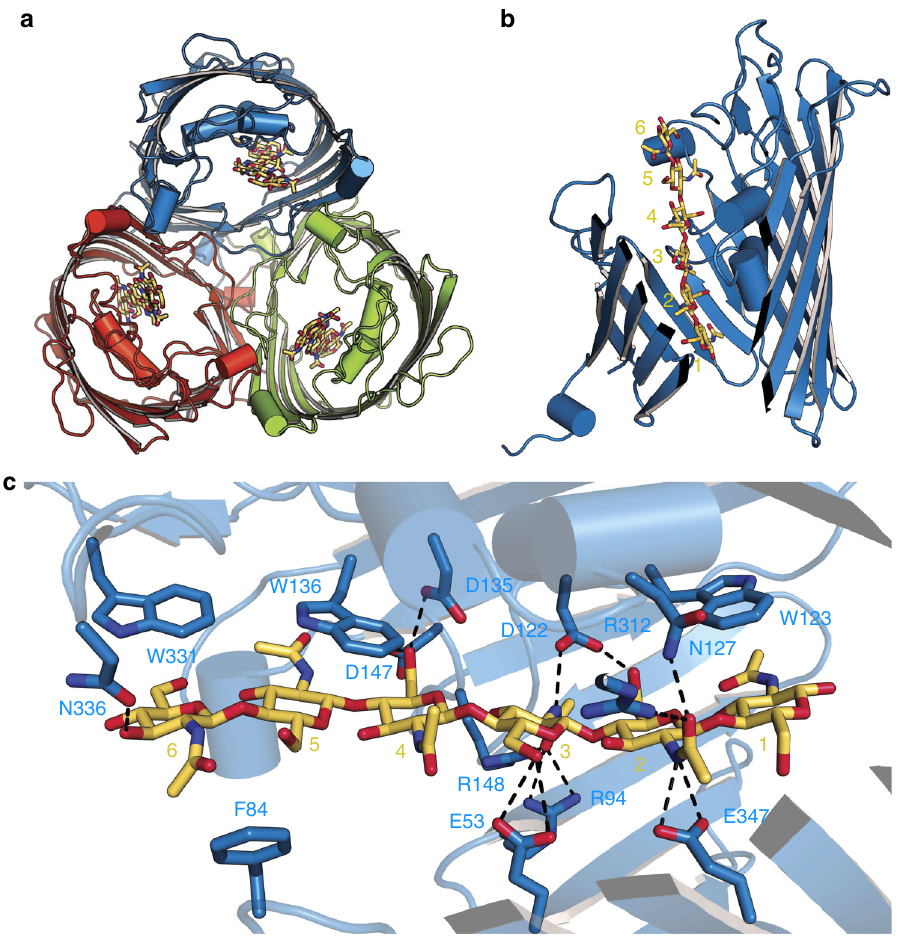
Fig. 4 Chitohexaose binding to in vitro-folded Vh ChiP. a Overview from the extracellular side. b Slabbed view from the side, with substrate residues labeled. c Schematic, showing interactions of key Vh ChiP residues with